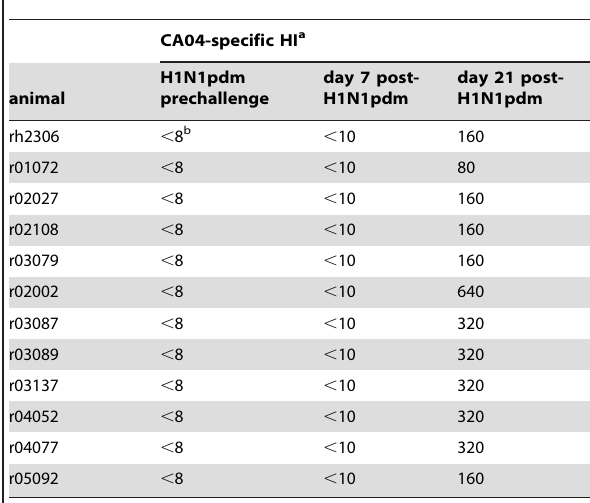
CA04. Detection limit 8 or 10, depending on lowest serum concentration